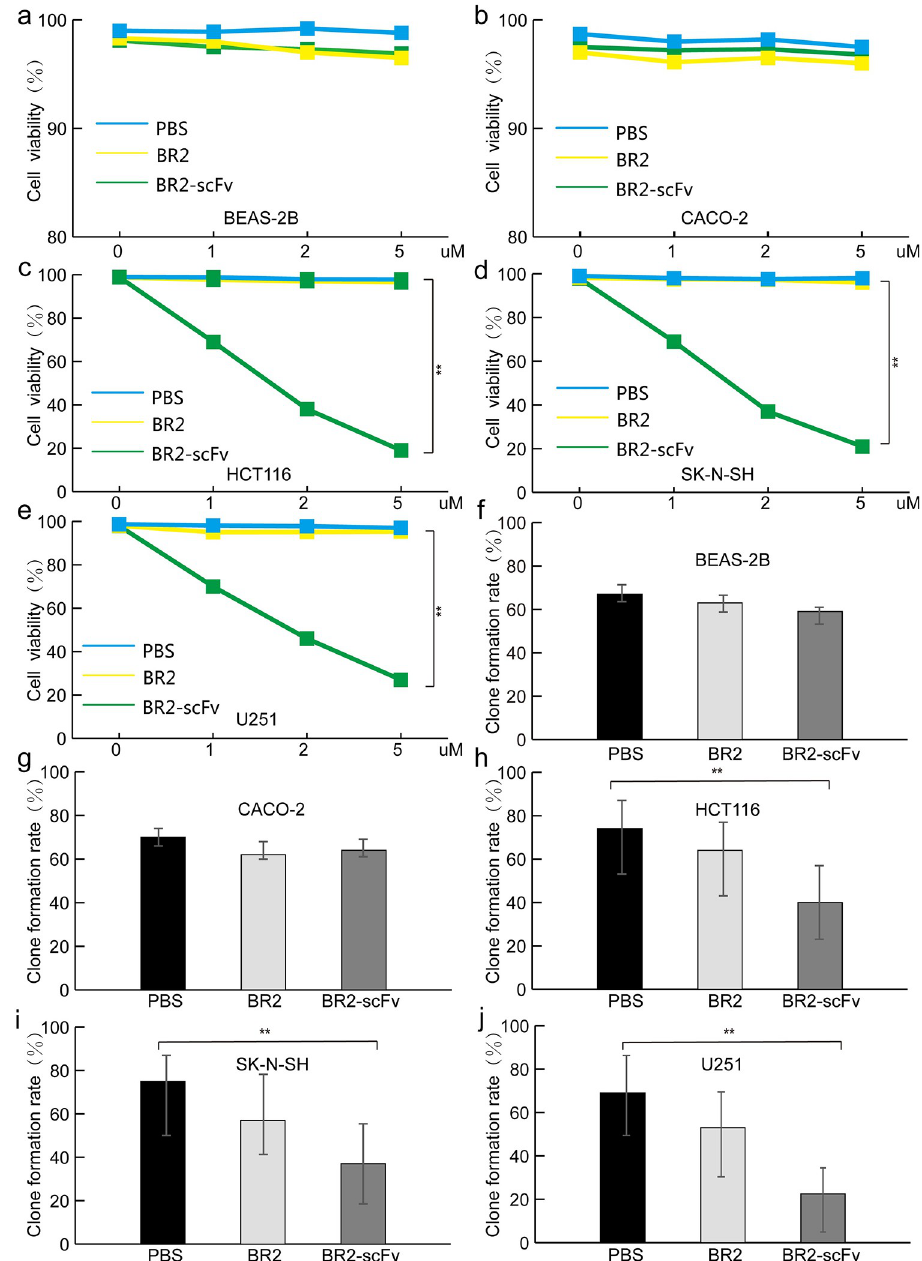
Fig 3. Effect of BR2-p21Ras scFv(BR2-scFv) on cell viability and clone formationm. ( a - e ) HCT116, SK-N-SH, U251, CACO-2 and BEAS-2B cells were treated with PBS, BR2, or BR2-scFv (0, 1, 2, and 5 μ M) and incubated at 37˚C for 24 h. Cell viability was measured with the MTT assay. Cell viability of tumor cells in the BR2-scFv group was significantly lower than that in the BR2 and PBS groups in HCT116, SK-N-SH, and U251 cells. ( f - j ) A clone formation experiment was performed to detect the effect of BR2-scFv on tumor cells proliferation. Tumor cells were incubated with 2 μ M fusion protein. After 2 weeks of incubation, monoclonal cells were stained with Giemsa. The clone formation rate of tumor cells in the BR2-scFv group was also significantly lower than that in the BR2 and PBS groups in HCT116, SK-N-SH, and U251 cells.